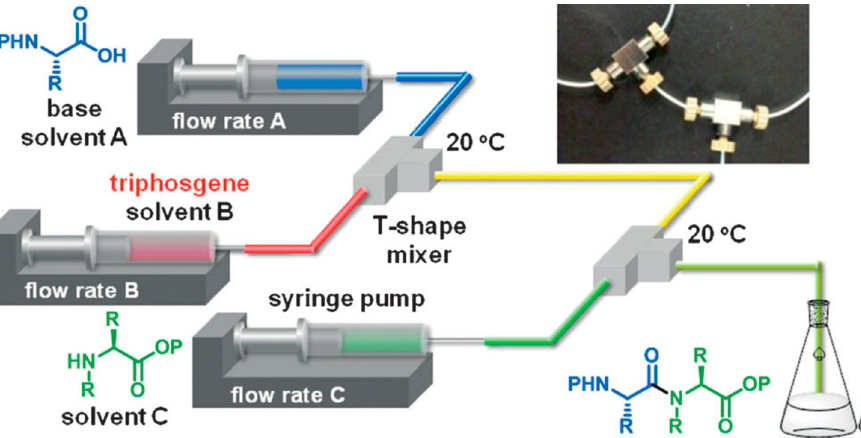
Figure 1. Microflow synthesis of peptides based on rapid and strong activation of carboxylic acids. Adapted with permission from Reference [13].